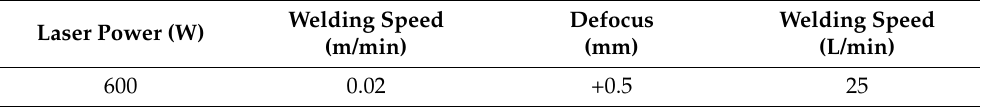
Table 4. Welding parameters for Ta and 304L.